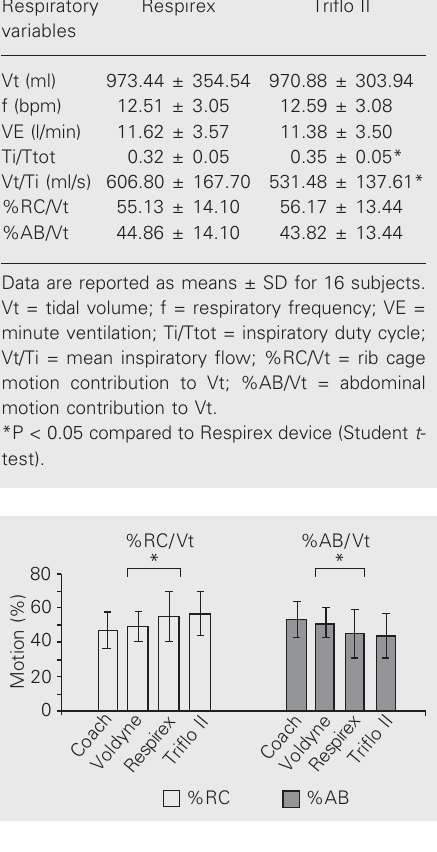
Table 2. Data obtained with flow-oriented incen- tive spirometers for healthy subjects. Respiratory